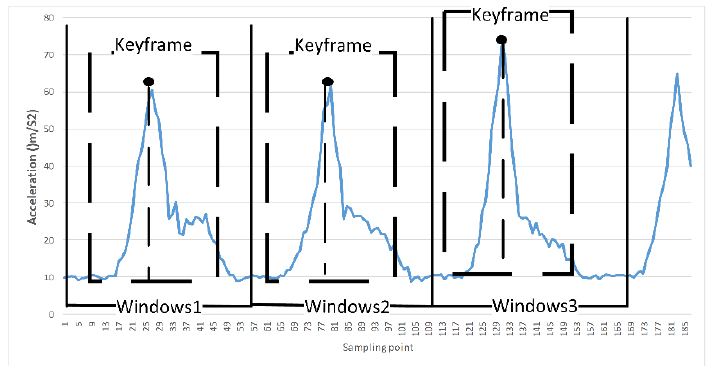
Figure 3. Schematic diagram of human table tennis action data window and key frame.